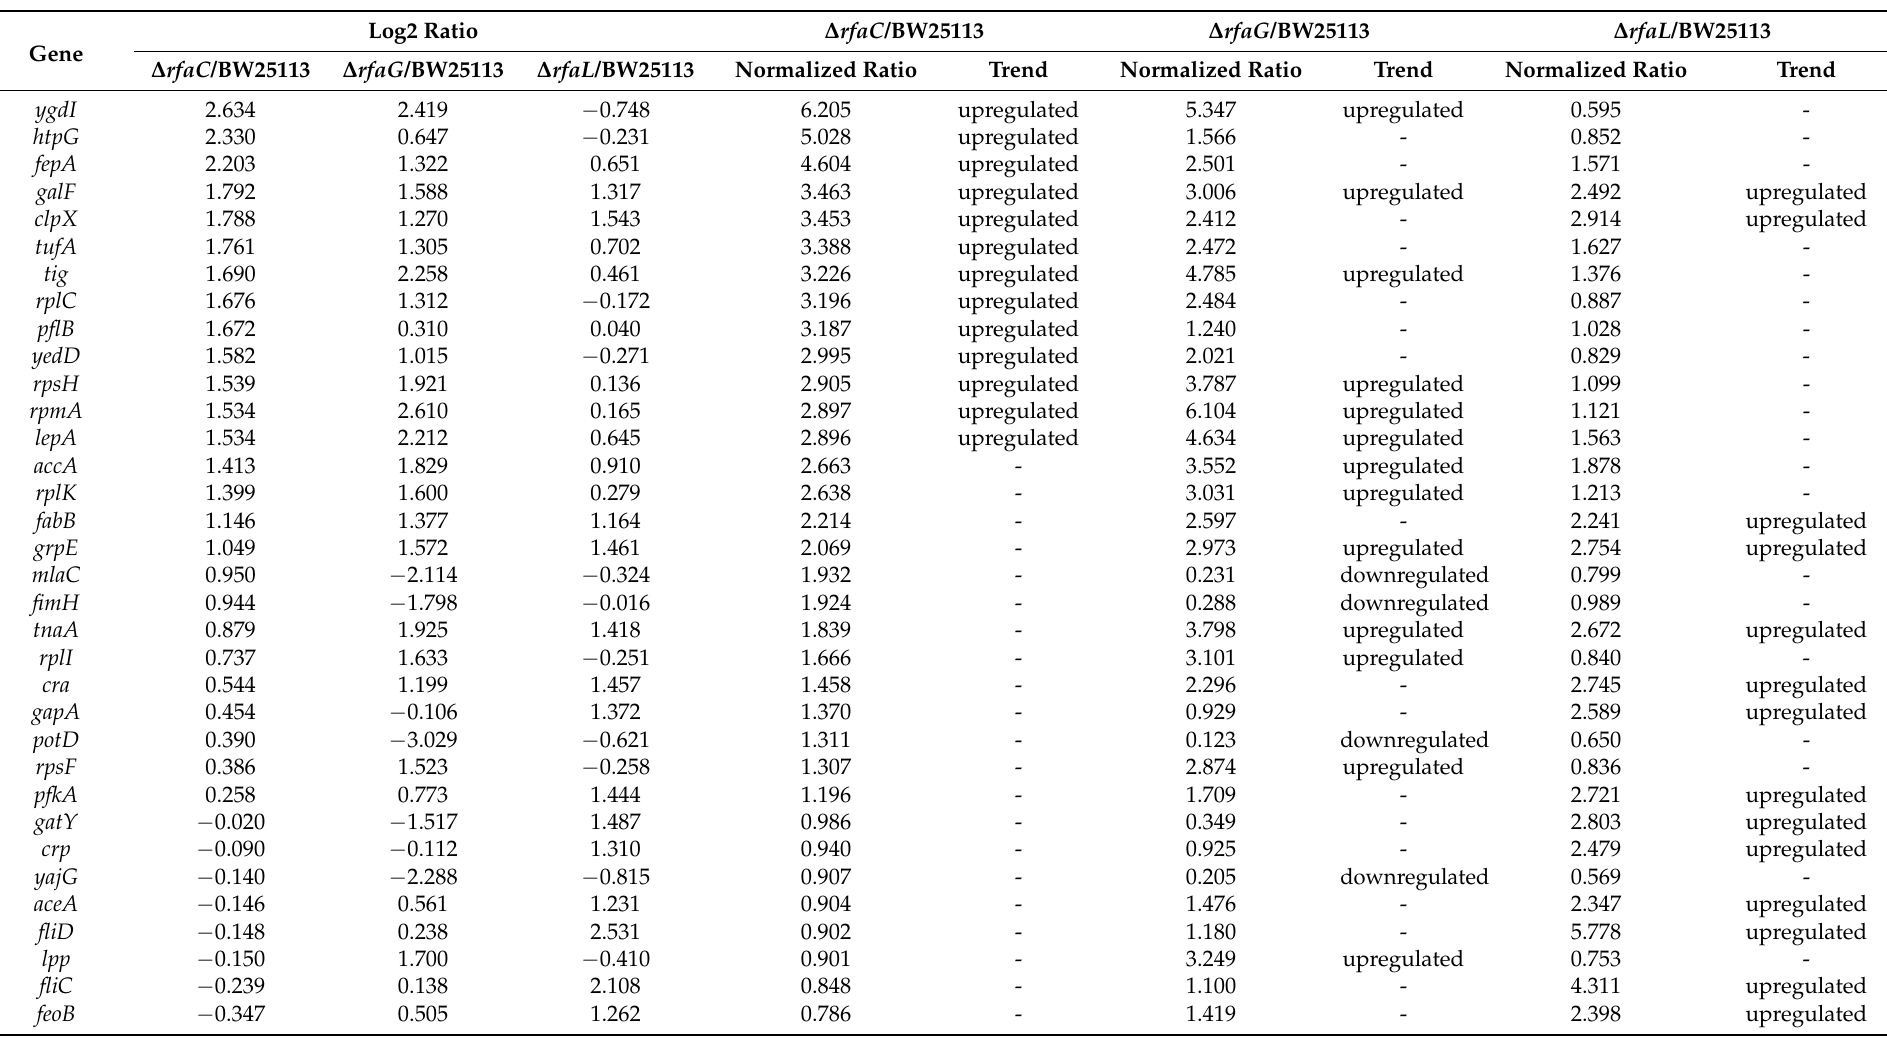
Table 3. Differentially expressed genes related with OMVs of genes in E. coli BW25113, rfaC knockout ( ∆ rfaC ), rfaG knockout ( ∆ rfaG ), and rfaL knockout ( ∆ rfaL )